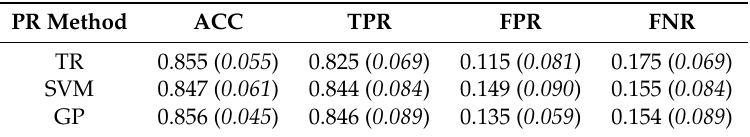
Table 7. Average and standard deviation ( in brackets ) of Accuracy (ACC), True Positive Rate (TPR), False Positive Rate (FPR) and False Negative Rate (FNR) the performance indicators for each recognition